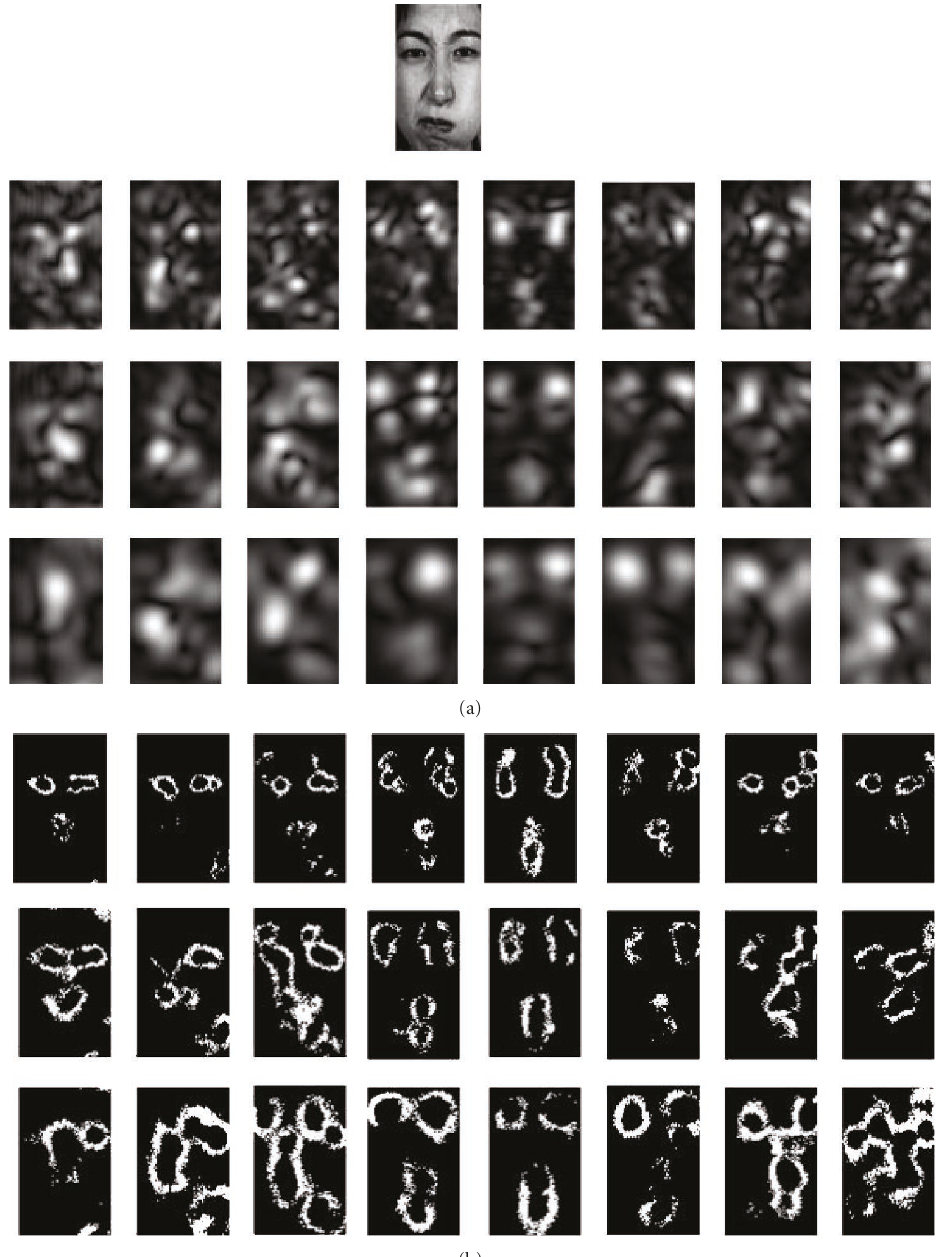
Figure 3: Example of the e ff ective Gabor filter of a face image with three scales and eight orientations. (a) Original Gabor features. (b) Points of the top ten percent of the Gabor features (white